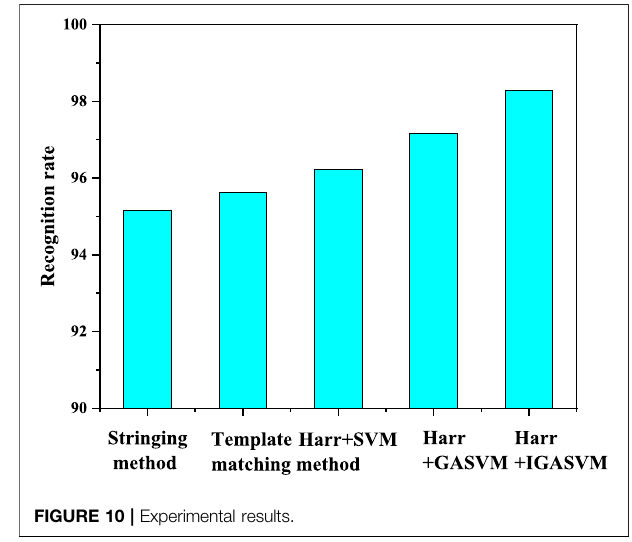
FIGURE 9 | Parameter optimization results of improved genetic algorithm.